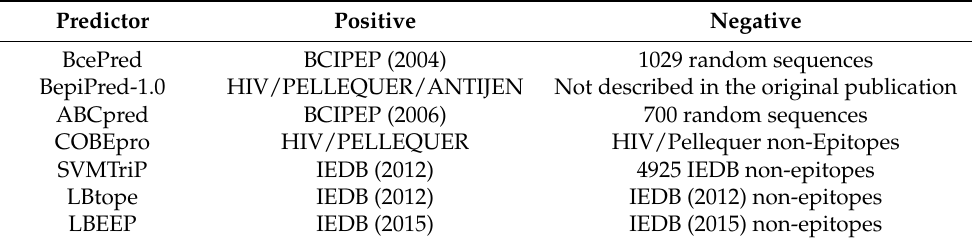
Table 4. A summary of the source of positive and negative data sets for each predictor. For every predictor, a database had to be used to construct its training data sets, which comprise of a positive and a negative subset of data. In this table, we outline the database or curated data set from which each method sourced its training data set, along with the date that the data was obtained. The date could be used to determine the snapshot of the data, which could have been obtained for each predictor’s training, allowing us to determine possible overlaps of our testing data set with the relevant training data. Predictor Positive Negative BcePred BCIPEP (2004) 1029 random sequences BepiPred-1.0 HIV/PELLEQUER/ANTIJEN Not described in the original publication ABCpred BCIPEP (2006) 700 random sequences COBEpro HIV/PELLEQUER HIV/Pellequer non-Epitopes SVMTriP IEDB